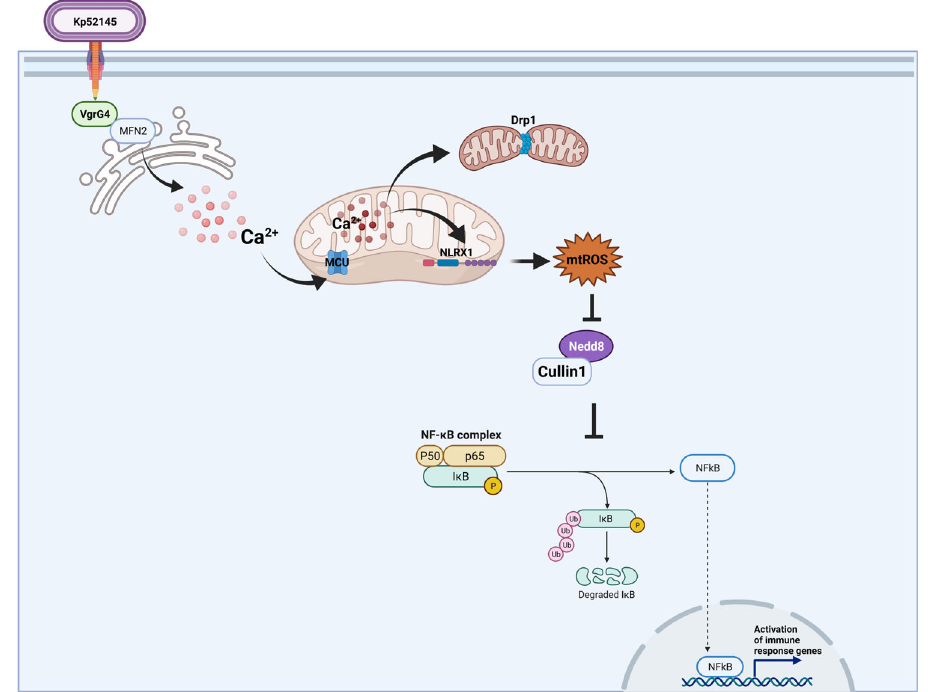
Fig. 7 | K. pneumoniae targets the mitochondria via its T6SS to promote infection. Working model of K. pneumoniae manipulation of the mitochondria in epithelial cells by exploiting its T6SS. Kp52145 injects the trans-kingdom T6SS effectorVgrG4into epithelialin aT6SS-dependentmanner.VgrG4colocalises with the ER-mitochondria tethering protein mitofusin 2 (MFN2). The ER localization of VgrG4resultsinthein fl uxofcalciumfromtheERtothemitochondriaviatheMCU channel. Mitochondria calcium induces the activation of Drp1 leading to the frag- mentation of the mitochondria network. Additionally, mitochondria